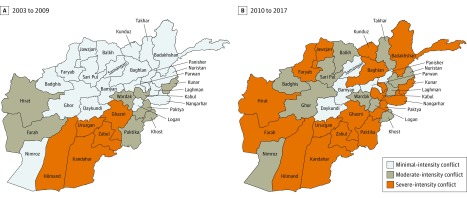
Conflict Intensity in Provinces of Afghanistan